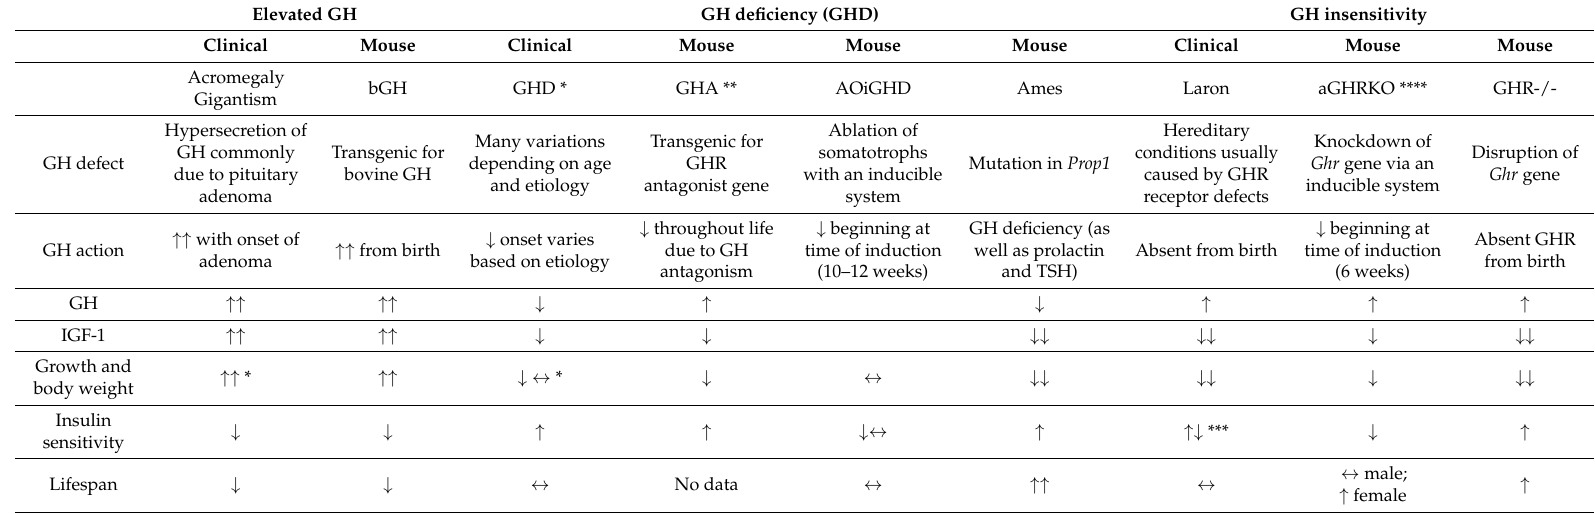
Table 1. Phenotypic summary of GH clinical conditions and comparable mouse